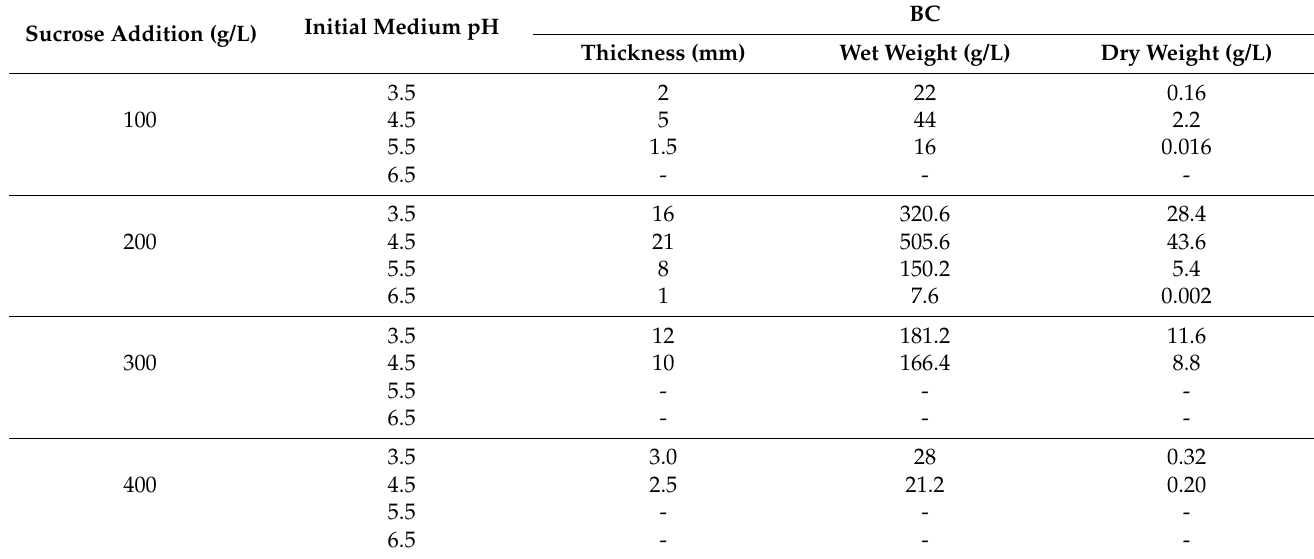
Table 2. Effect of the sucrose addition and initial medium pH on